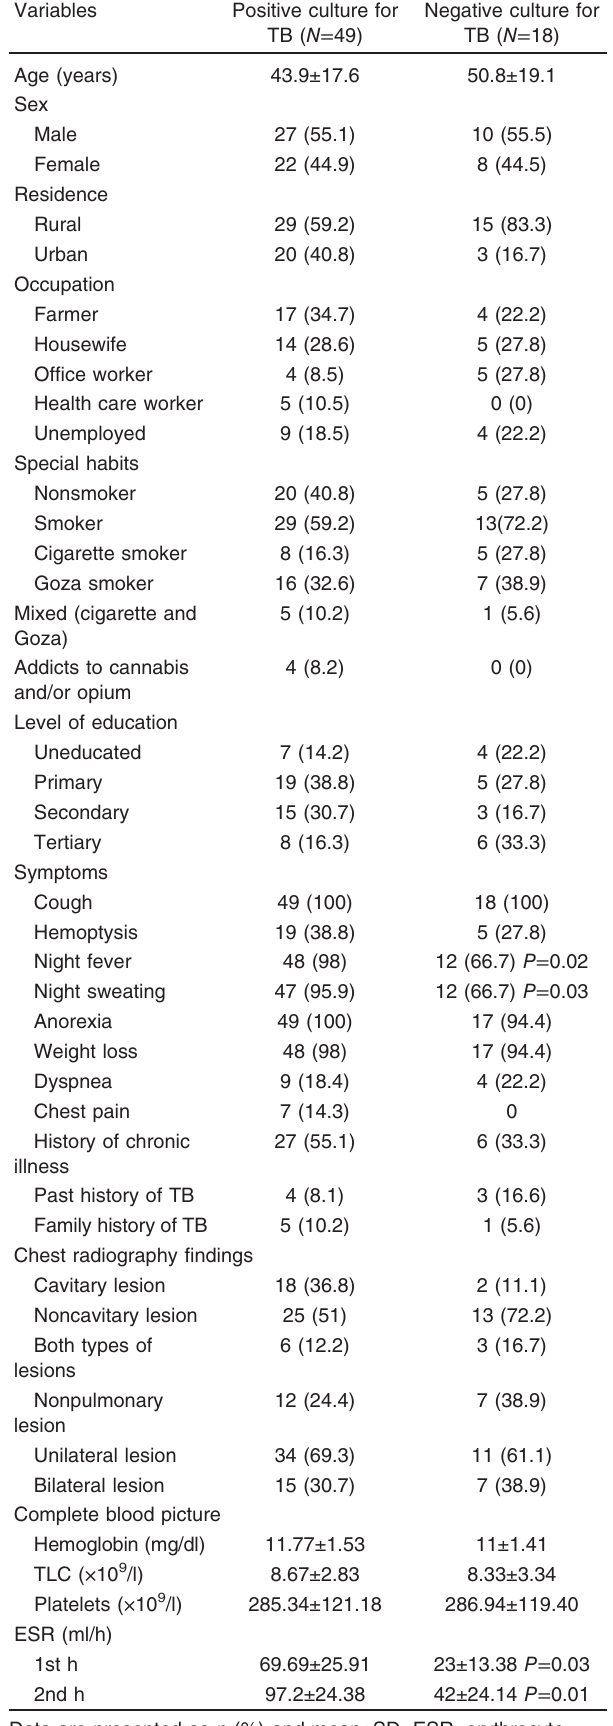
Table 1 Characteristics of patients enrolled in the study ( N = 67)